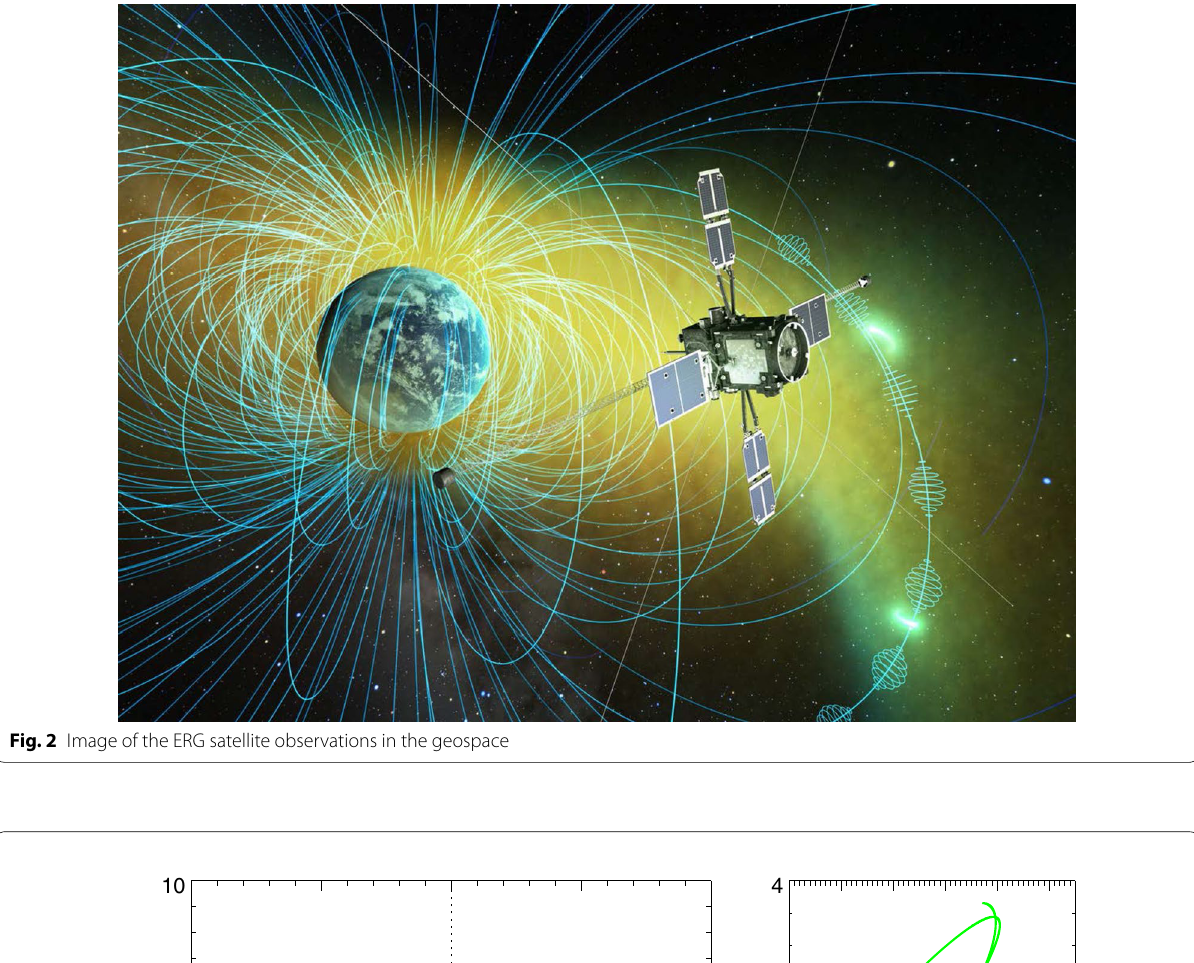
Fig. 2 Image of the ERG satellite observations in the geospace